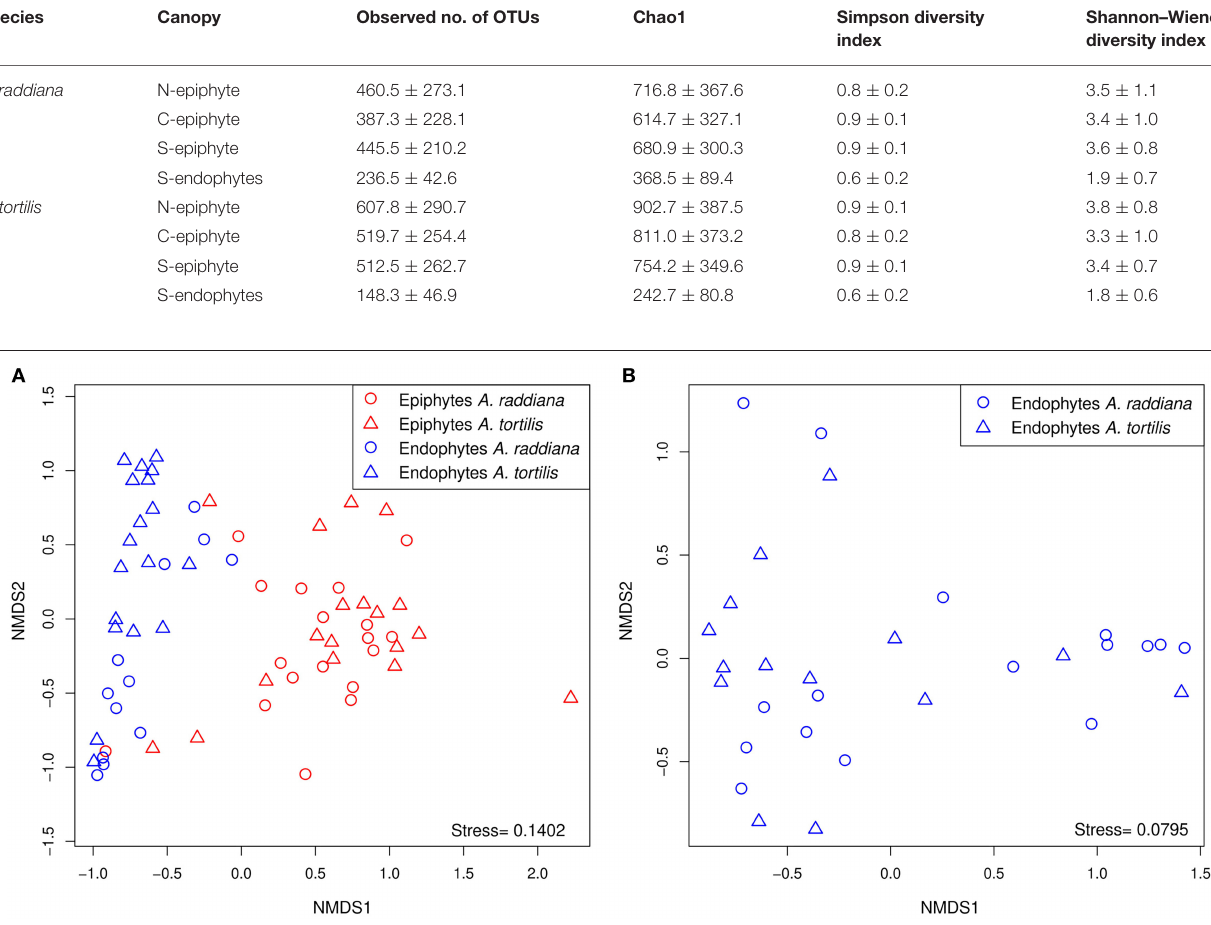
TABLE 1 | Average diversity estimates ( ± SD) of microbial communities of A. raddiana and A. tortilis measured across the entire sampling months for the epiphyte at north (N) and center (C) canopy sides and for both epiphytes and endophytes at south (S) canopy side. Species